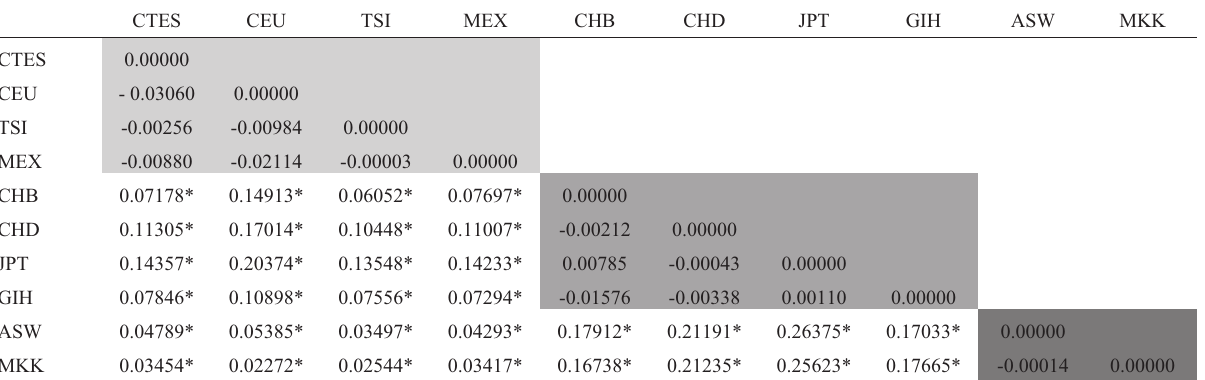
Table 1 - Genetic distances between populations. Values indicate population pairwise Fst. Shadings indicate the continental origin of populations as fol- lows: light gray block = European and American, gray block = Asian, dark gray block = African populations. Asterisks mark statistically significant val- ues (significance test: 1023 permutations, p <